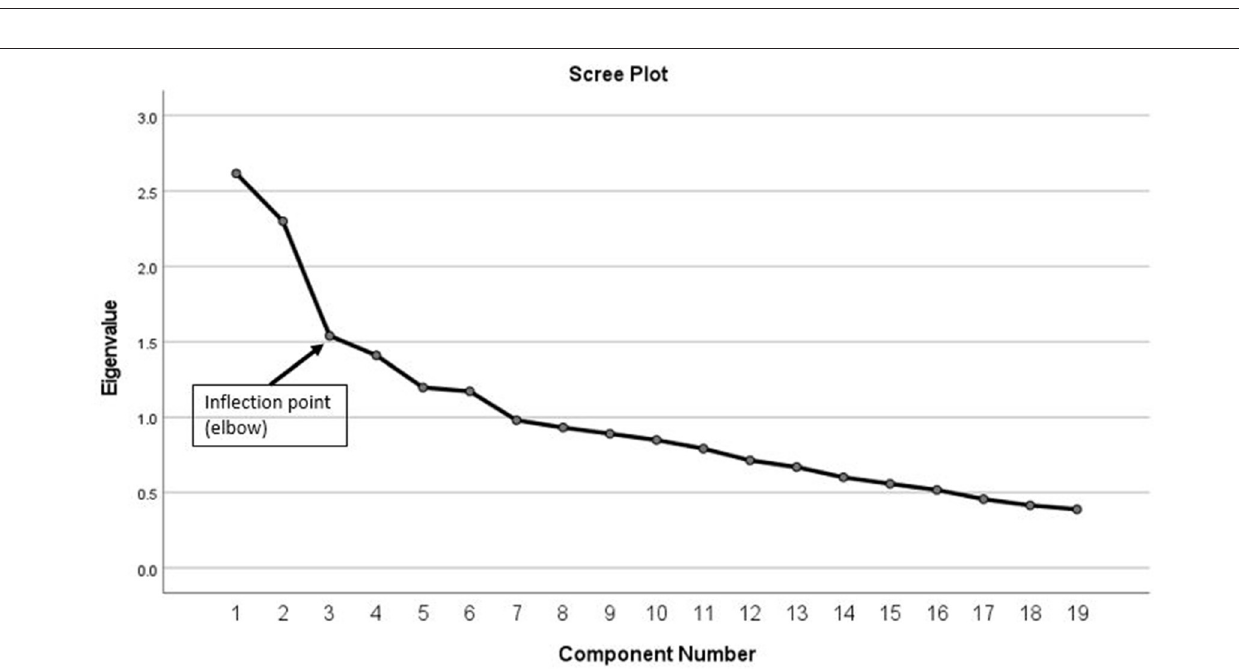
FIGURE 2 | Scree plot, as derived from the principal component analysis (PCA) of the dietary intake among study population ( n = 194).